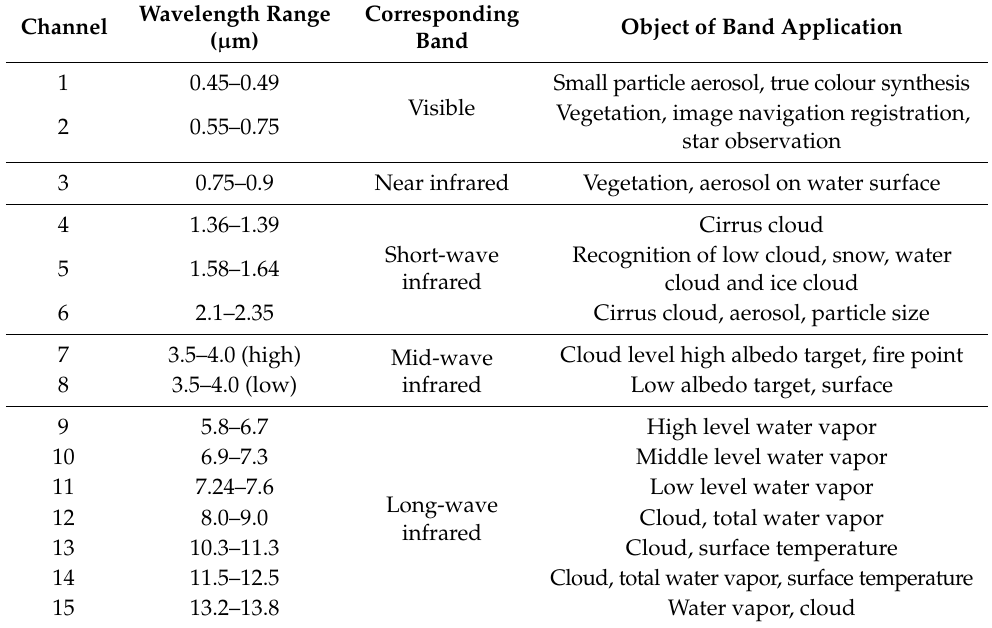
Table 2. Wavelength range of different AGRI channels and application objects of each channel.